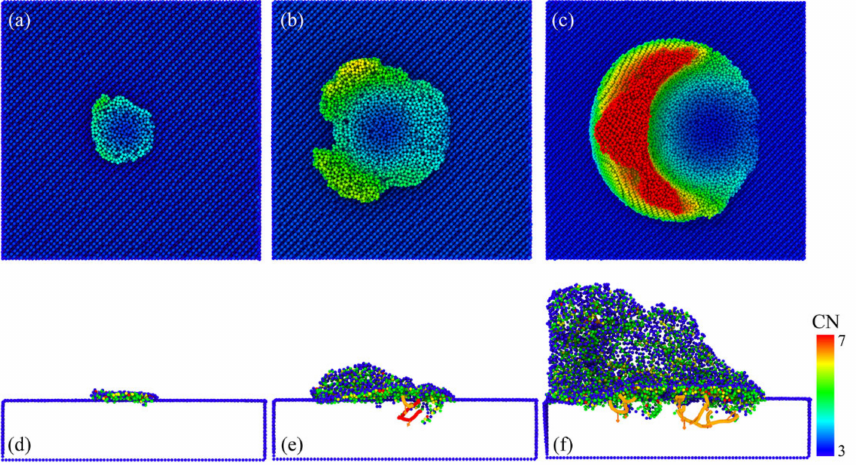
Figure 9. ( a – c ) and ( d – f ) represent the surface morphology at significant cracks and the defect structure at plow completion at asperity radii of 2 nm, 4 nm and 7 nm,